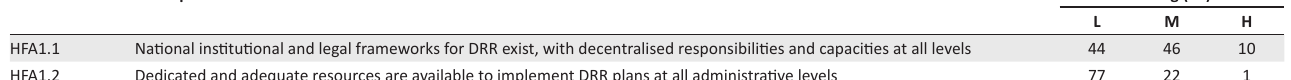
TABLE 2: Perceptions of respondents with regard to achieving Hyogo Framework for Action 1: Making disaster risk reduction a national and local priority. Indicator code